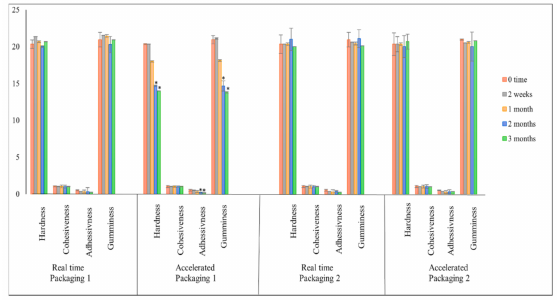
Figure 5. The texture profile analysis (TPA) of paracetamol instant jelly samples stored in packaging 1 and packaging 2 at different time points (0, 2 weeks, 1, 2, and 3 months). Error bars represent standard deviation, * symbol indicate significant differences ( p -value < 0.05).